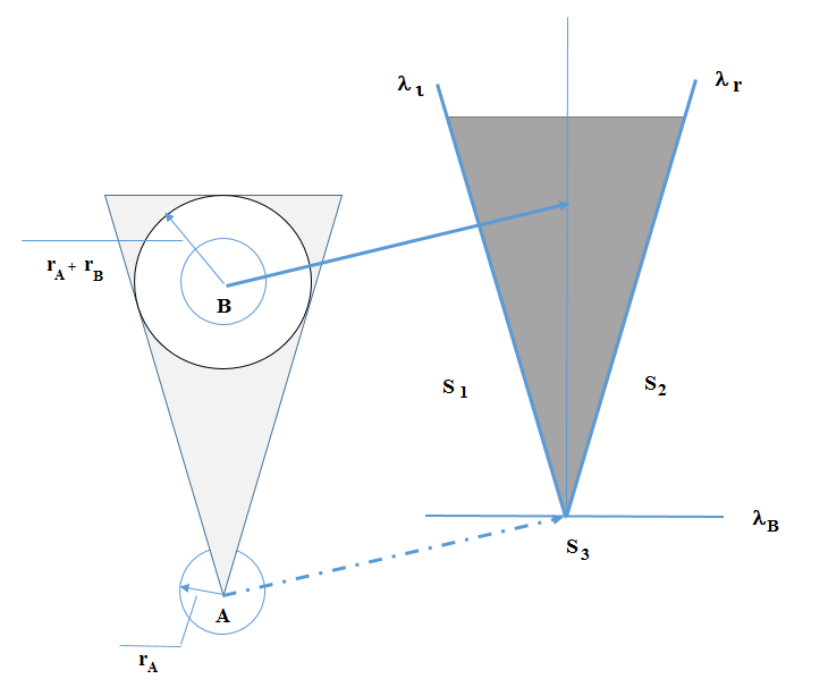
Figure 7. Vehicle A considers vehicle B as an obstacle. It shows that vehicle A has three regions, S 1, S 2, and S 3, around the velocity obstacle.